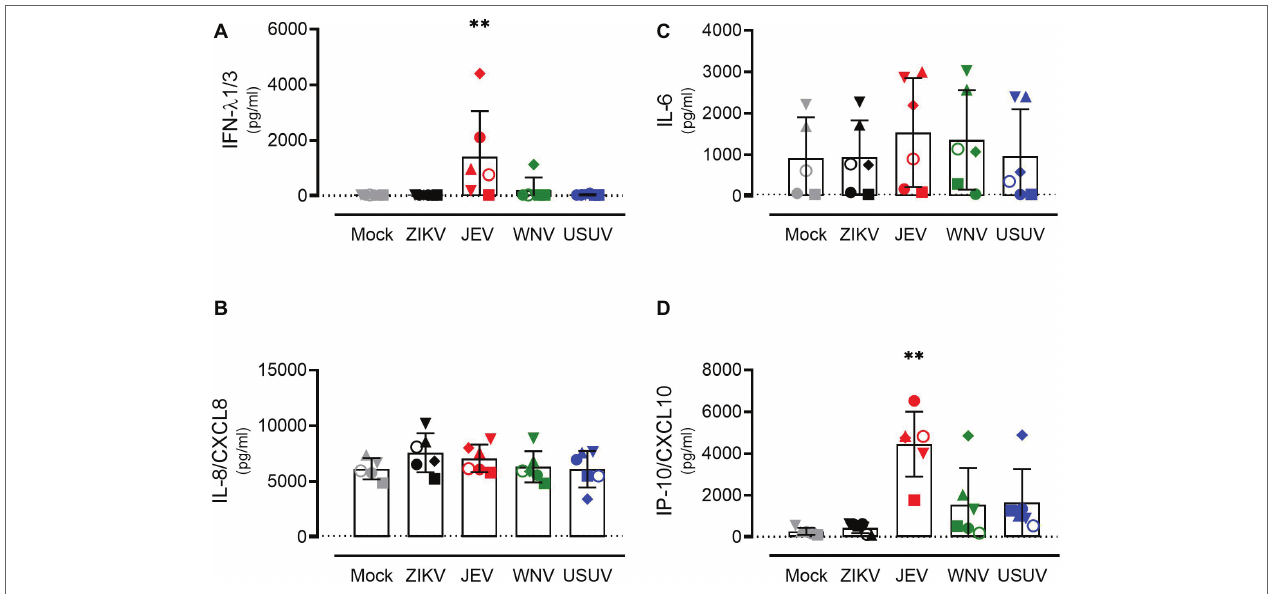
FIGURE 4 | Protein expression levels of antiviral mediators and pro-inflammatory cytokines by NECs after flavivirus infection. IFN- λ 1/3 (A) , IL-8/CXCL8 (B) , IL-6 (C) , and IP-10/CXCL10 (D) protein levels measured by ELISA. Each symbol represents an independent donor (donor I: dot, donor II: square, donor III: upward triangle, donor IV: diamond, donor V: circle, and donor VI: downward triangle). Data are represented as mean and SD and stars indicate significance levels. ** p < 0.01. The dashed lines indicate the detection limits of the ELISA assays (IFN- λ 1/3: 40 pg/ml, IL-8/CXCL8: 120 pg/ml, IL-6: 43 pg/ml, and IP-10/CXCL10: 22 pg/ml).